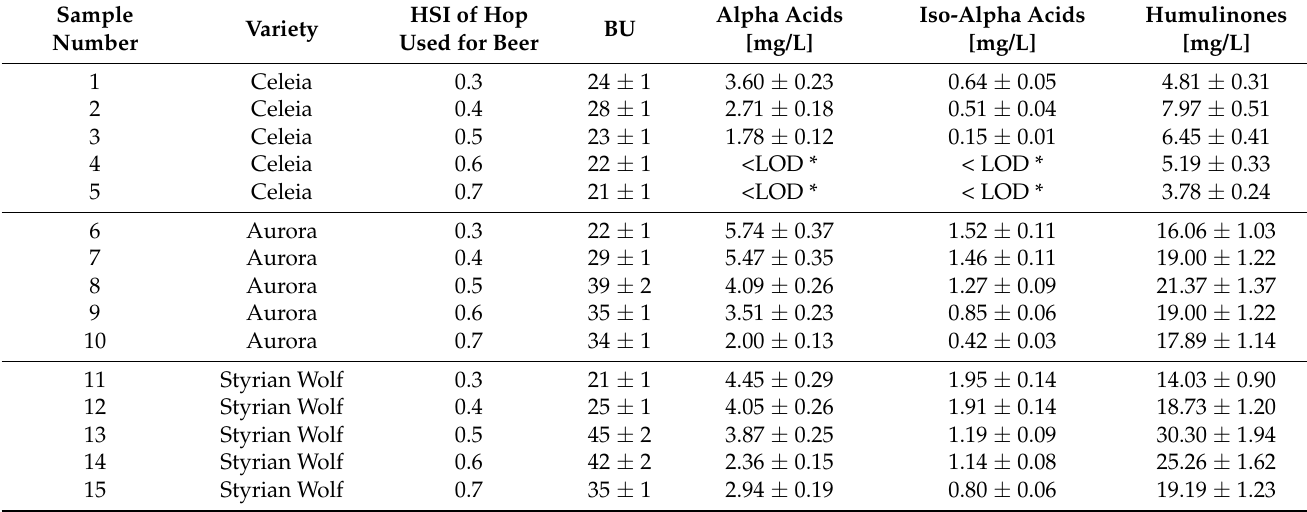
Table 5. Bitterness units, concentrations of alpha acids, iso-alpha acids and humulinones in beer samples, presented as mean value ± standard deviation. LOD stands for limit of